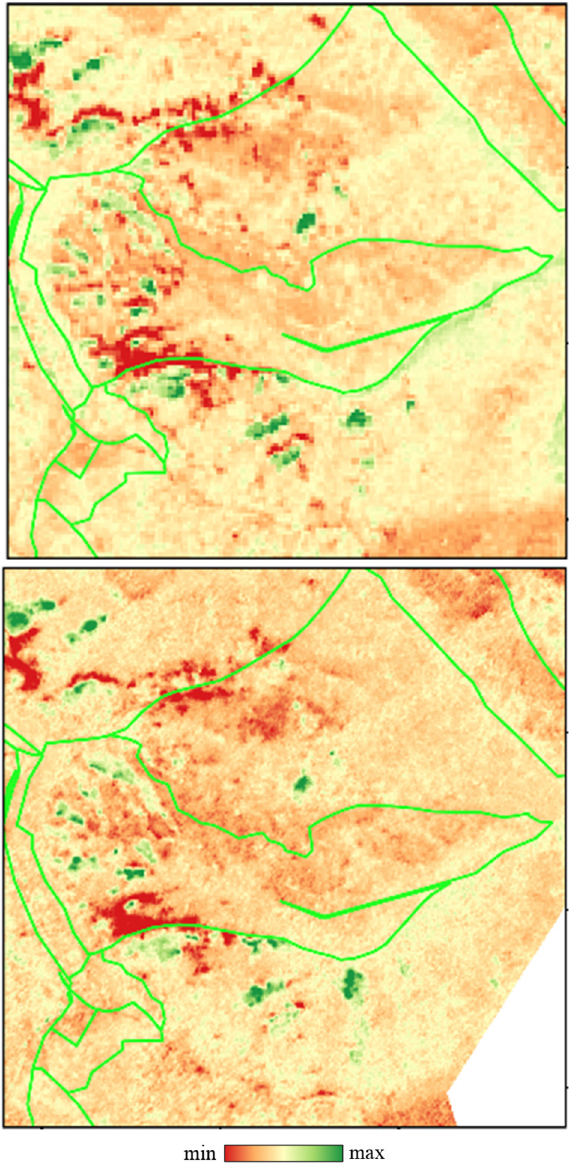
Figure 5. Automatically forest degradation map based on S2 10-m imagery (above) and 3-m forest degradation map (below) for forest compartment/subcompartment 17A (base map: digital orthophoto